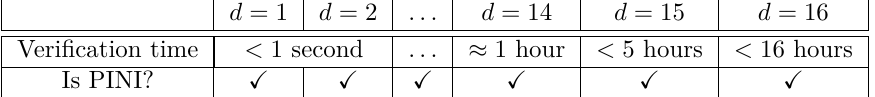
Table 1: Verification outcomes of Mul d +1 using our optimized tool. d = 1 d = 2 . . . d = 14 Verification